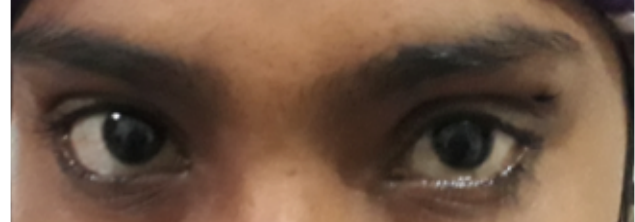
Fig 1. Ectopic cilia on left upper lid in primary gaze